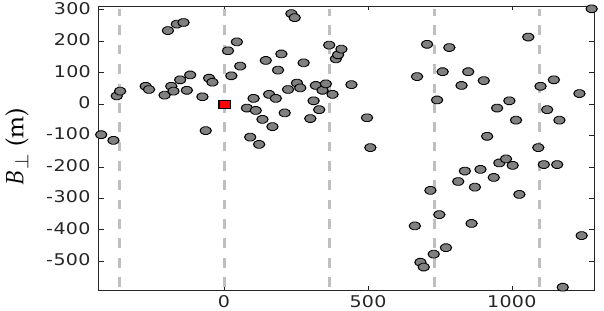
Figure 1. Perpendicular baselines (in meter) between the master image ( (cid:4) ) and the other 97 images composing the interferometric dataset given the number of days between the acquisitions. The vertical dashed lines represent the years from the reference image.